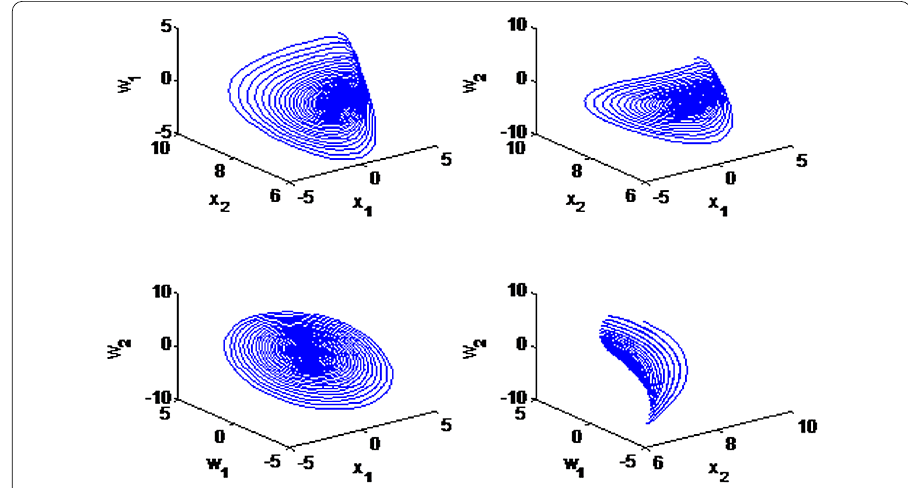
Figure 3 Chaotic attractors of system (3) in 3D spaces with u 1 = 0.001, u 2 = 0.0002, q 1 = 0.19, q